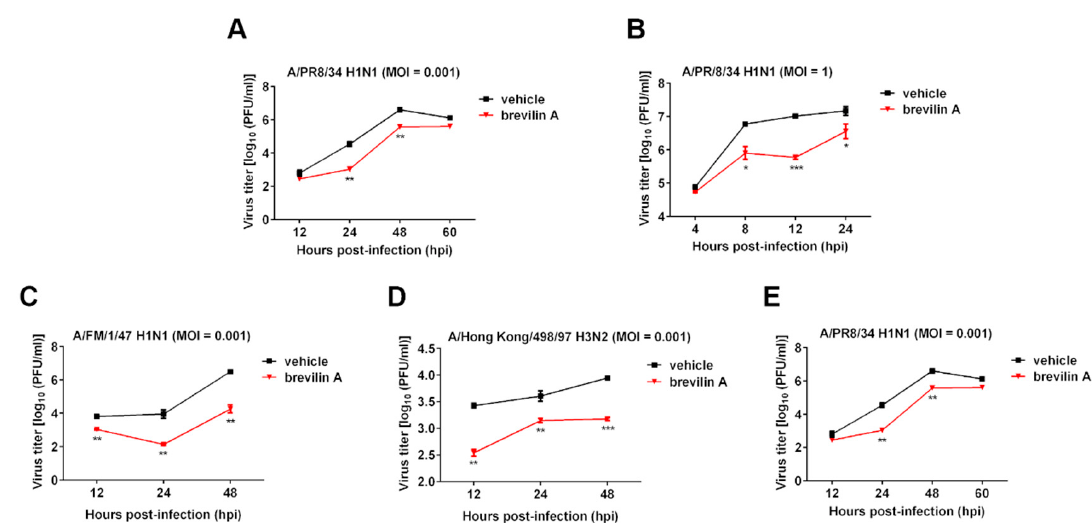
Figure 2. The inhibitory effect of brevilin A on the growth curves of various influenza A viruses (IAV) strains. Madin–Darby canine kidney (MDCK cells) were infected with influenza A / PR / 8 / 34 H1N1 virus at a MOI of 0.001 ( A ) or 1 ( B ), or A / FM / 1 / 47 H1N1 virus ( C ), A / Hong Kong / 498 / 97 H3N2 virus ( D ), or A / chicken / Guangdong / 1996 H9N2 virus ( E ) at a MOI of 0.001. Cells were then treated with 8 µ M of brevilin A or vehicle. At the indicated time points after infection, virus titers in the supernatants were determined by a plaque assay. The data represent means ± SD. *, p < 0.05; **, p < 0.01; ***, p < 0.001 are considered statistically significant, compared to vehicle.